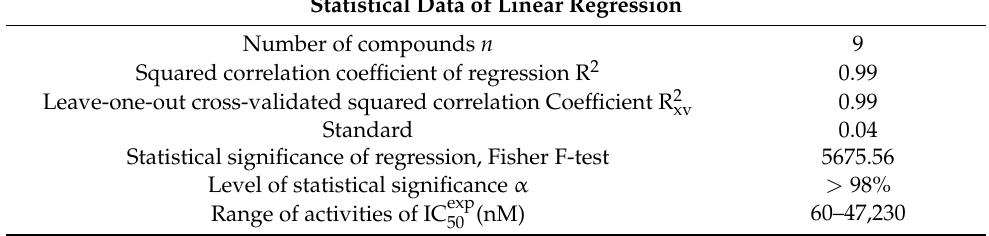
(cid:17) (cid:16) × 10 − 9 = = − log IC exp 10 50 50